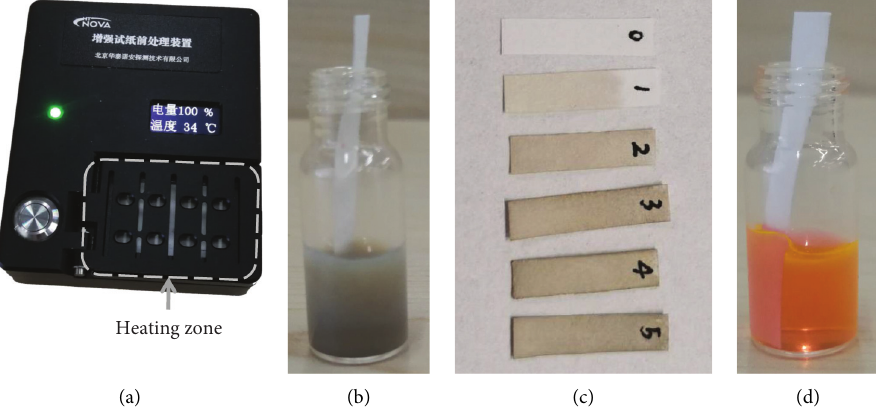
Figure 1: (a) The photo of the microheater, (b) the dip-coating of a test strip into colloidal AgNPs, (c) the prepared test strips with different cycles of dip-coating and heating, and (d) the target sampling of Rh6G solution with a prepared test